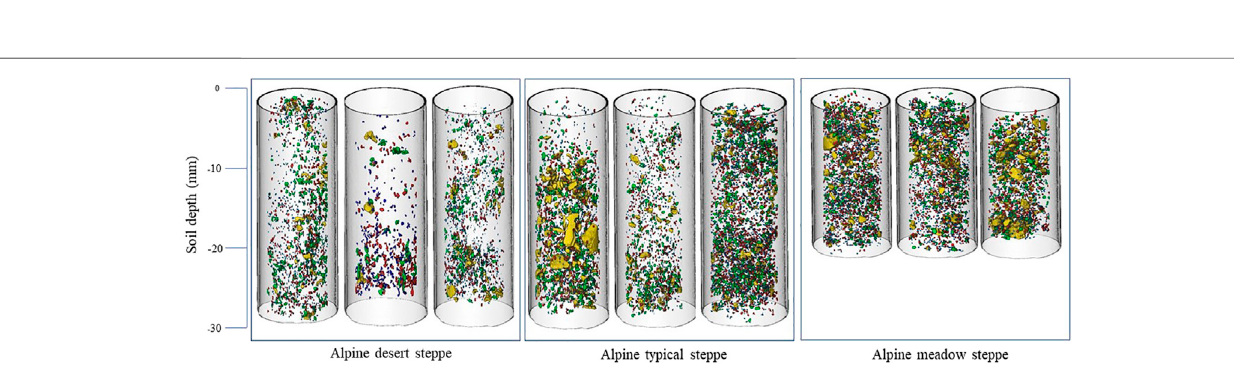
Frontiers in Environmental Science |